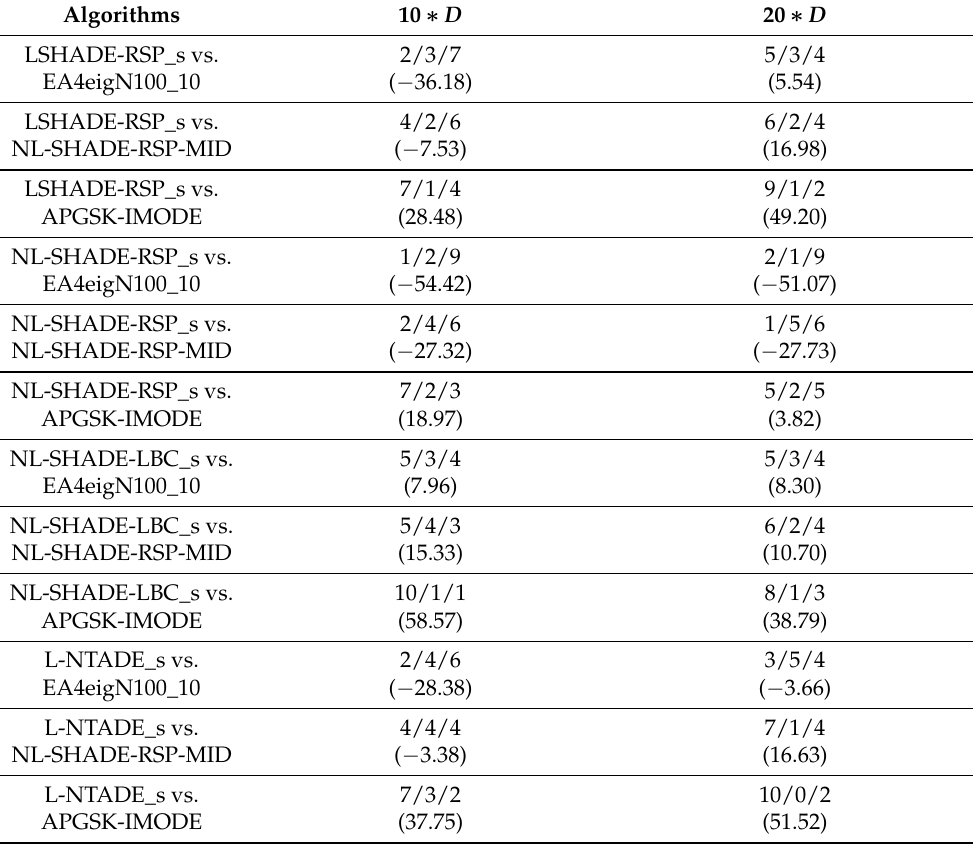
Table 8. Algorithms with crossover rate sorting vs. alternative approaches, CEC 2022, Mann–Whitney tests and total standard